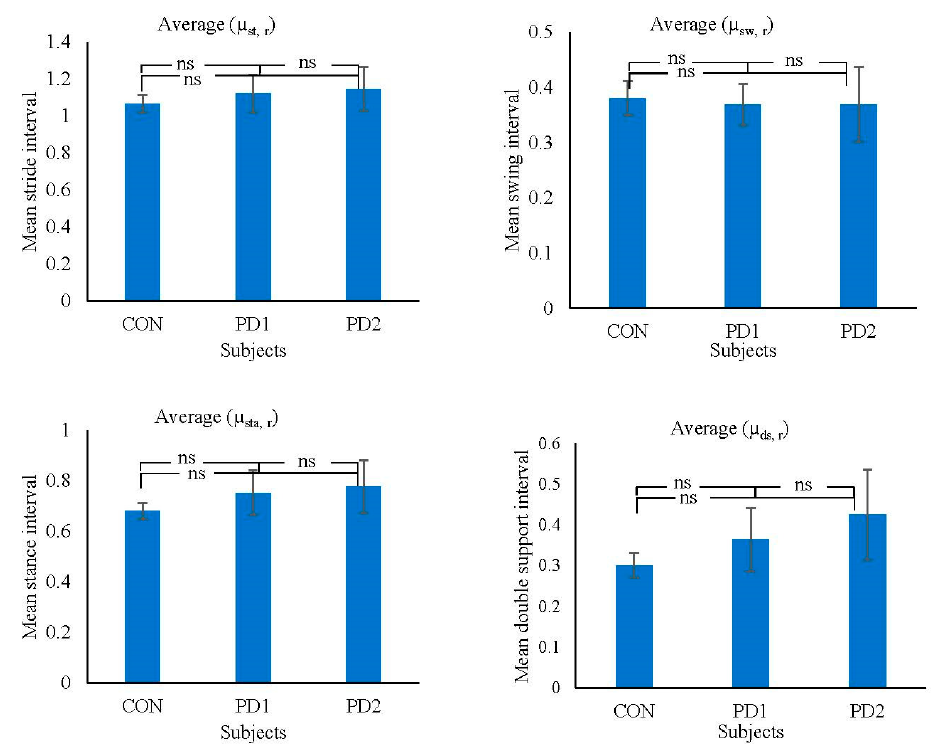
Figure 3. Bar chart showing the mean stride, swing, stance, and double-support intervals for CON, PD1, and PD2 subjects (significance ( p ) = nonsignificant (ns)).